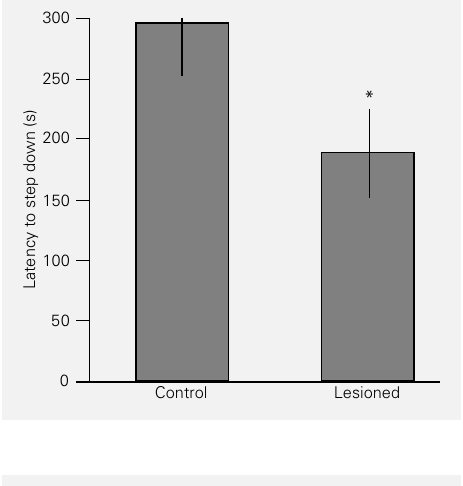
Figure 7 - Effect of a post-train- ing lesion of the entorhinal cor- tex on performance in an open field task. Data are reported as means ± SEM (N = 10 animals/ group). There were no signifi- cant differences between groups (P>0.05, Student t -test). *P<0.005 compared to the train- ing session (paired Student t -